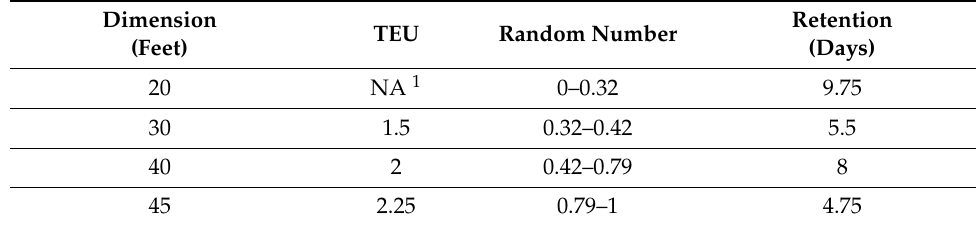
Table 12. Simulation of container retention according to container dimension.